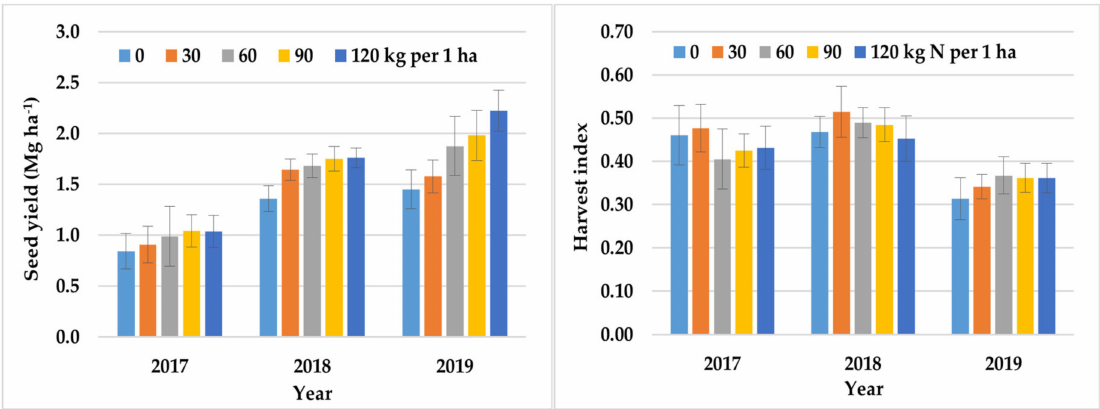
Figure 4. The e ff ect of N fertilization on crambe seed yields and harvest index across growing seasons (2017–2019). Error bars represent the standard deviation.